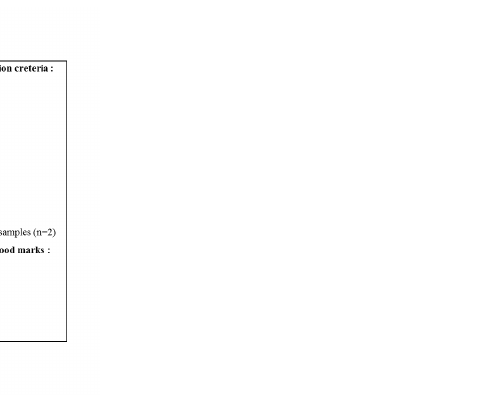
Fig 1. Flow chart describing the selection of the study population. 459 subjects were finally recruited for